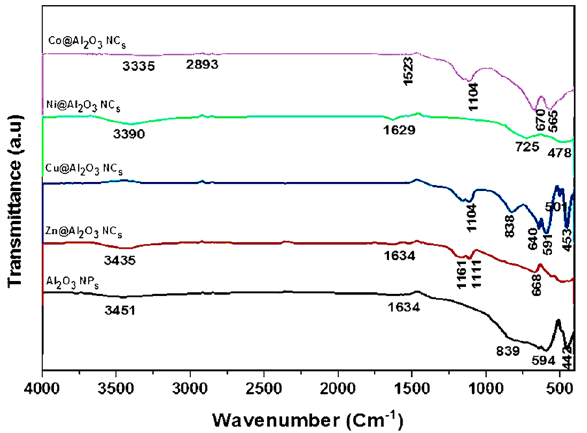
Figure 2. FTIR spectra of Al2O3 NPs, ZnAl2O4, CoAl2O4, NiAl2O4, and CuAl2O4 nanocomposites at 1100